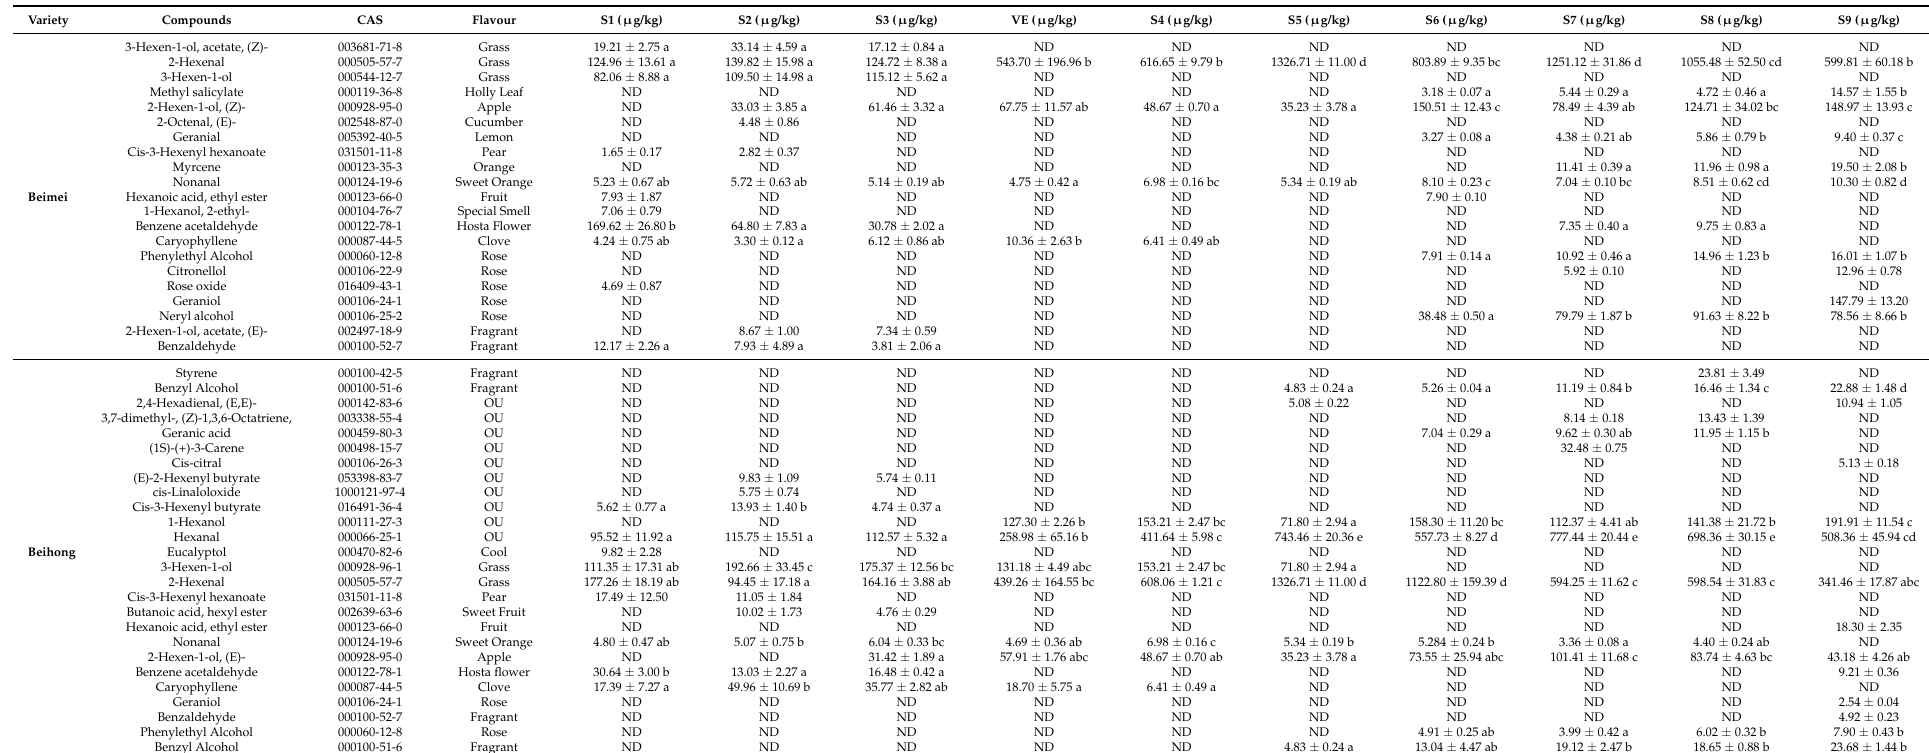
Table A1. Changes of flavor compounds at different sampling date in developmental stages of “Bei” wine grape varieties.